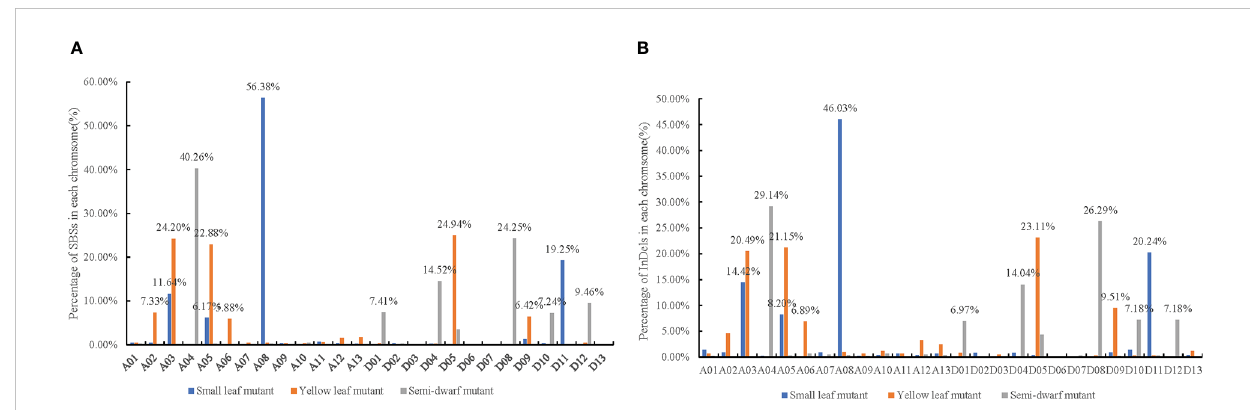
FIGURE 4 The pecentage of SBS and InDels mutations in each chromosome induced by CIB irradiation among three mutation lines. (A) The pecentage of SBS mutations in each chromosome among three mutation lines. (B) The pecentage of InDels mutations in each chromosome among three mutation